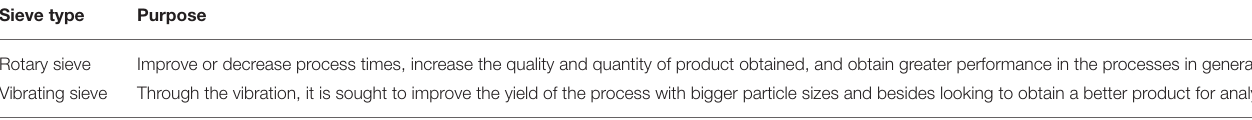
TABLE 4 | Equipment used for screening and its purpose.